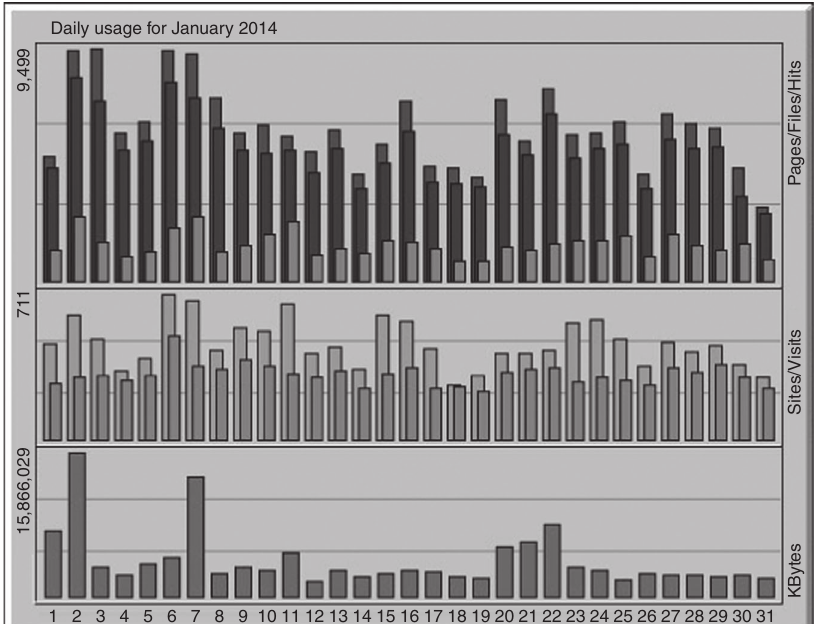
Figure 3. Daily usage